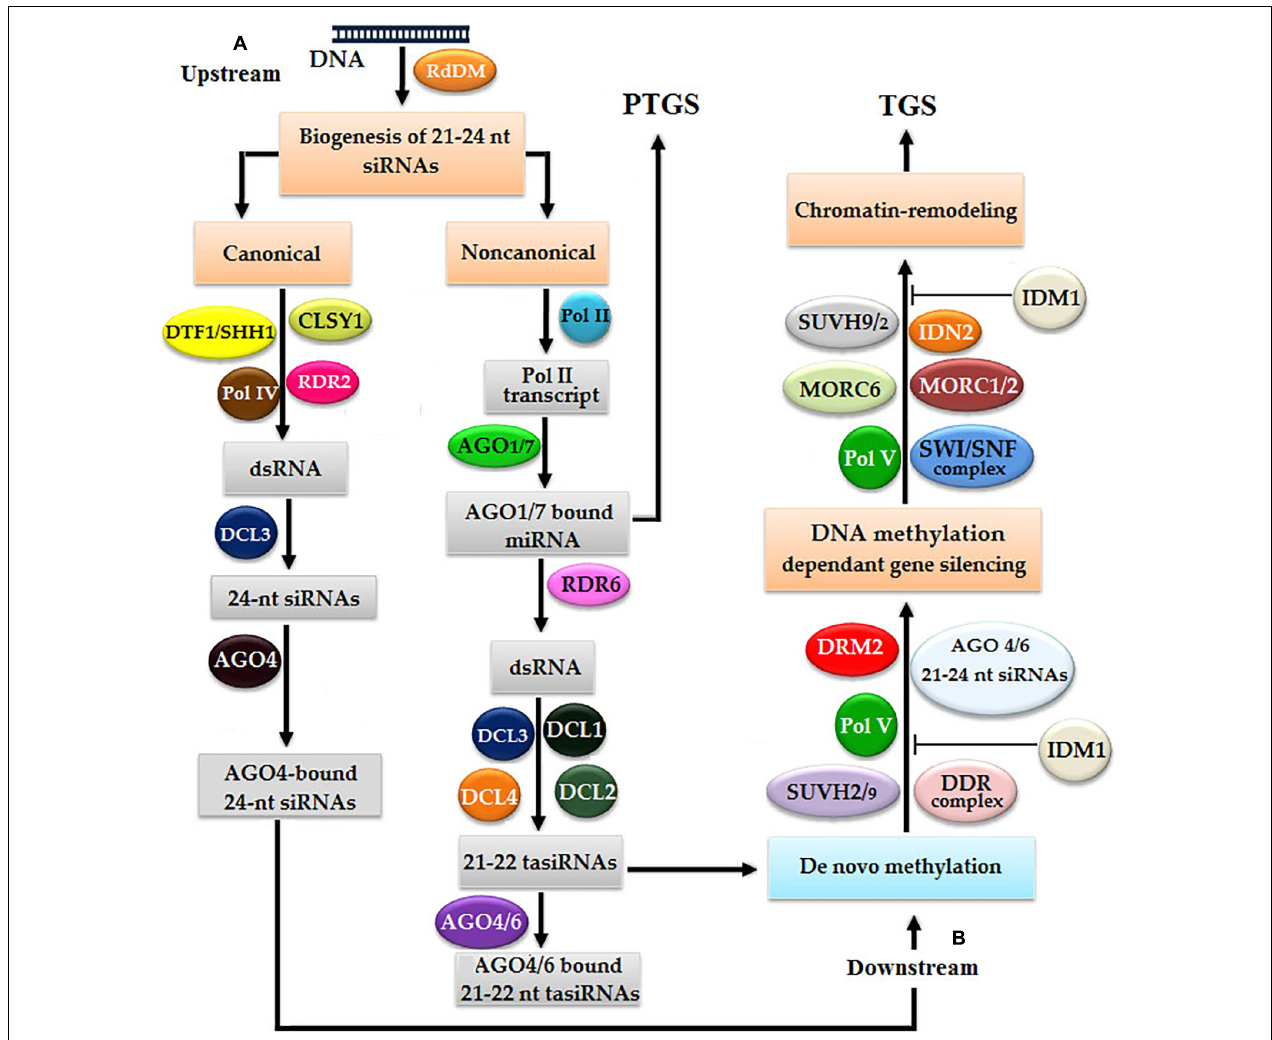
FIGURE 2 | Arabidopsis models of RNA-directed DNA methylation (RdDM): double-stranded RNAs (dsRNAs) proceed into small-interfering RNAs (siRNAs) via canonical and non-canonical pathways. Both pathways undergo two steps: (A) in the first step, siRNAs are produced, which subsequently bind with argonaut (AGO) and (B) in the second step, DNA methylation leads to chromatin remodeling resulting in gene silencing via transcriptional gene silencing